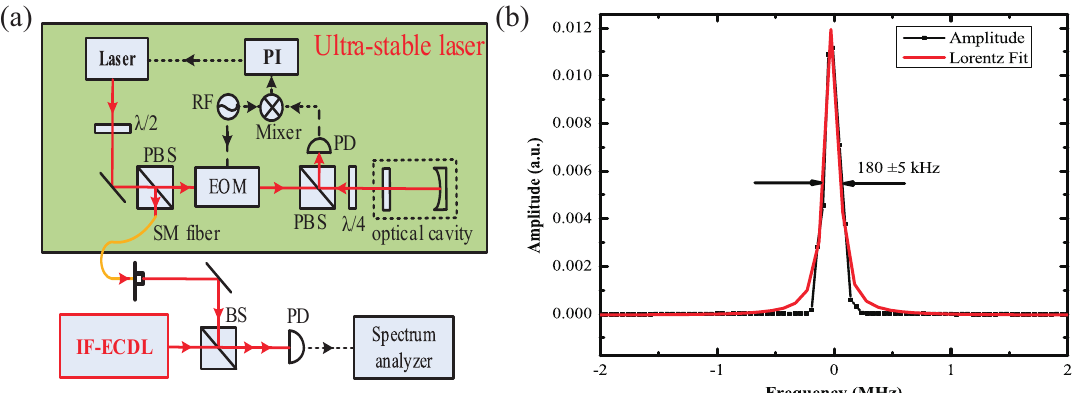
Figure 10. ( a ) Beat experiment involving the IF-ECDL and an ultra-stable laser with the linewidth of about 1 Hz. ( b ) Spectrum of beat signal between ECDL and a 698 nm laser with ultra-narrow linewidth. The injection current of the laser during the measurement is 64 mA, and The temperature is 22.3 ◦ C. The resolution bandwidth of the spectrum analyzer is 10 kHz, and The sweep time is 1.29 s. The black line shows the power spectrum of the beat signal, and The red line indicates a fitted